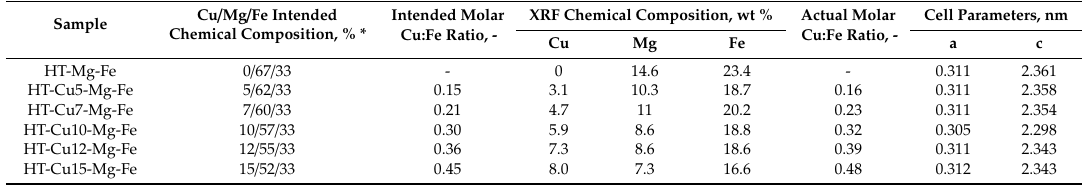
Table 1. Physico-chemical properties of Cu-Mg-Fe hydrotalcite precursors.